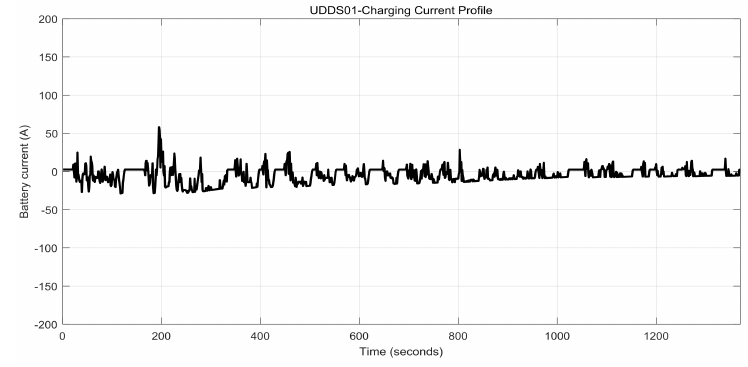
Figure 17. The UDDS driving cycle charging current profile